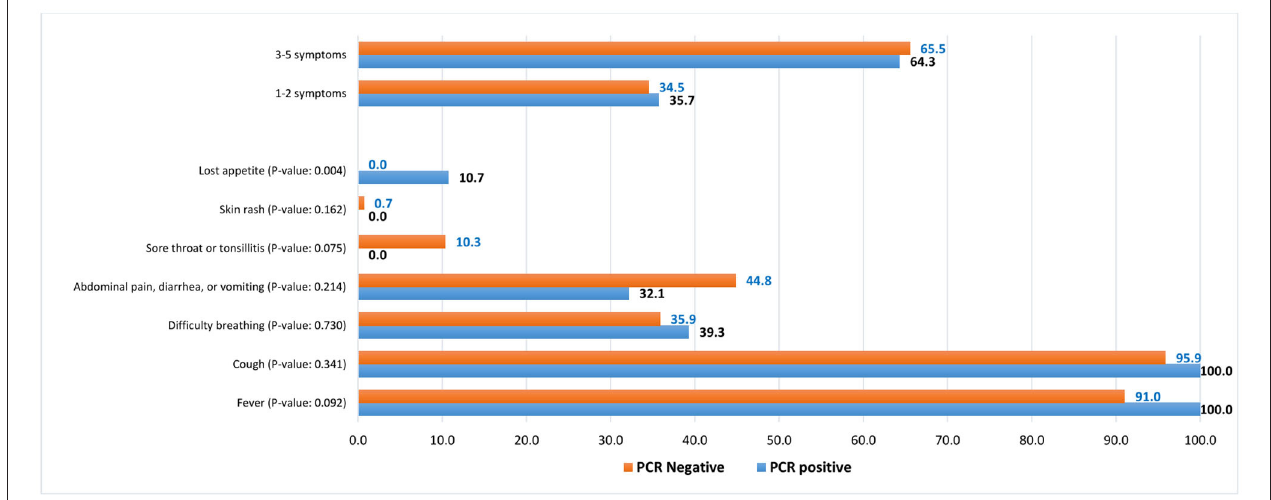
FIGURE 1 | Symptoms distribution among COVID-19 RT-PCR-positive and clinically suspected COVID-19 (RT-PCR-negative) pediatric patients,